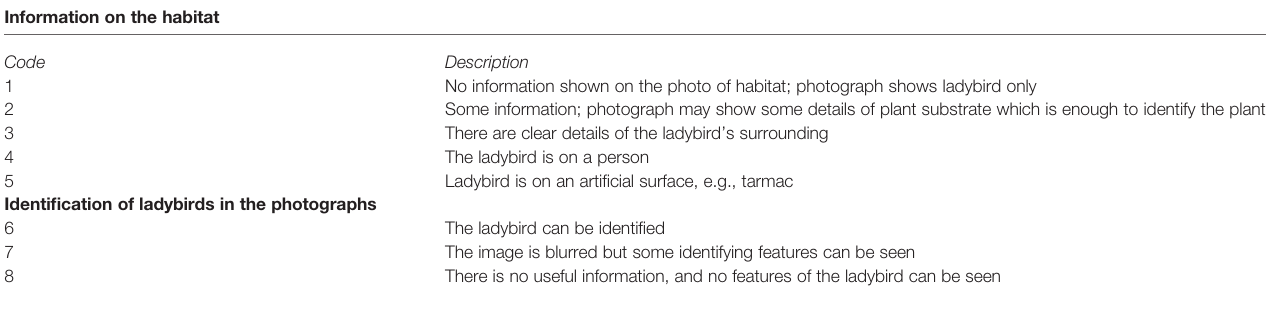
TABLE 1 | Criteria used for assessment of photographs of ladybirds submitted by members of the public. Information on the